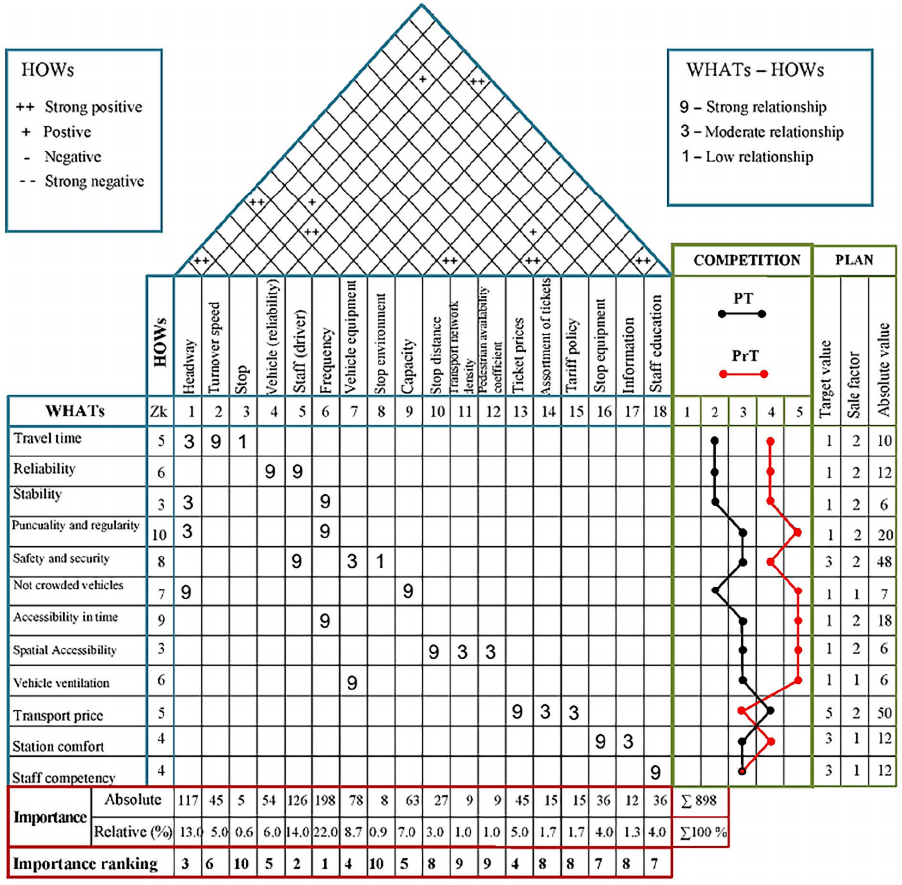
Figure 5. Implementation of house of quality in quality of service development in urban public transport passenger system in